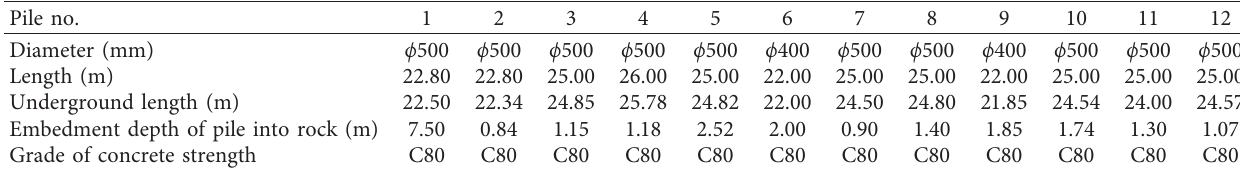
Table 4: Characteristics of test piles at the hard rock bearing stratum site.